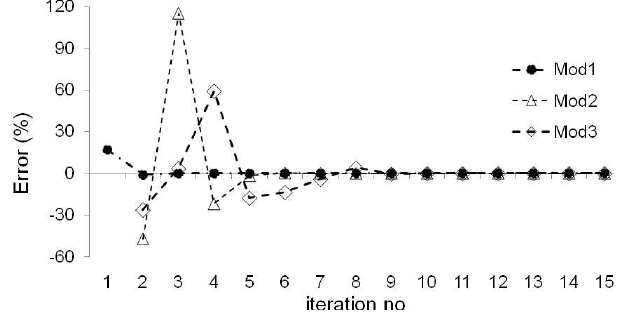
Figure 2. Variation of errors with iterations for the first three